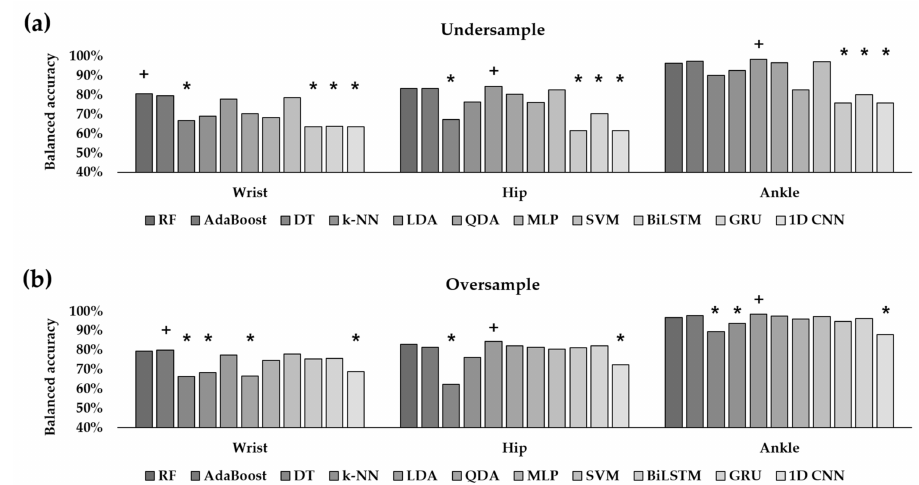
Figure 8. Balanced accuracies of eight feature-based ML classifiers and three DL classifiers in the ( a ) undersampling approach and ( b ) oversampling approach. The cross mark (+) denotes the classifier that exhibited the best performance. The asterisk (*) denotes the classifiers which were significantly different ( p < 0.05) from the best classifier after post hoc